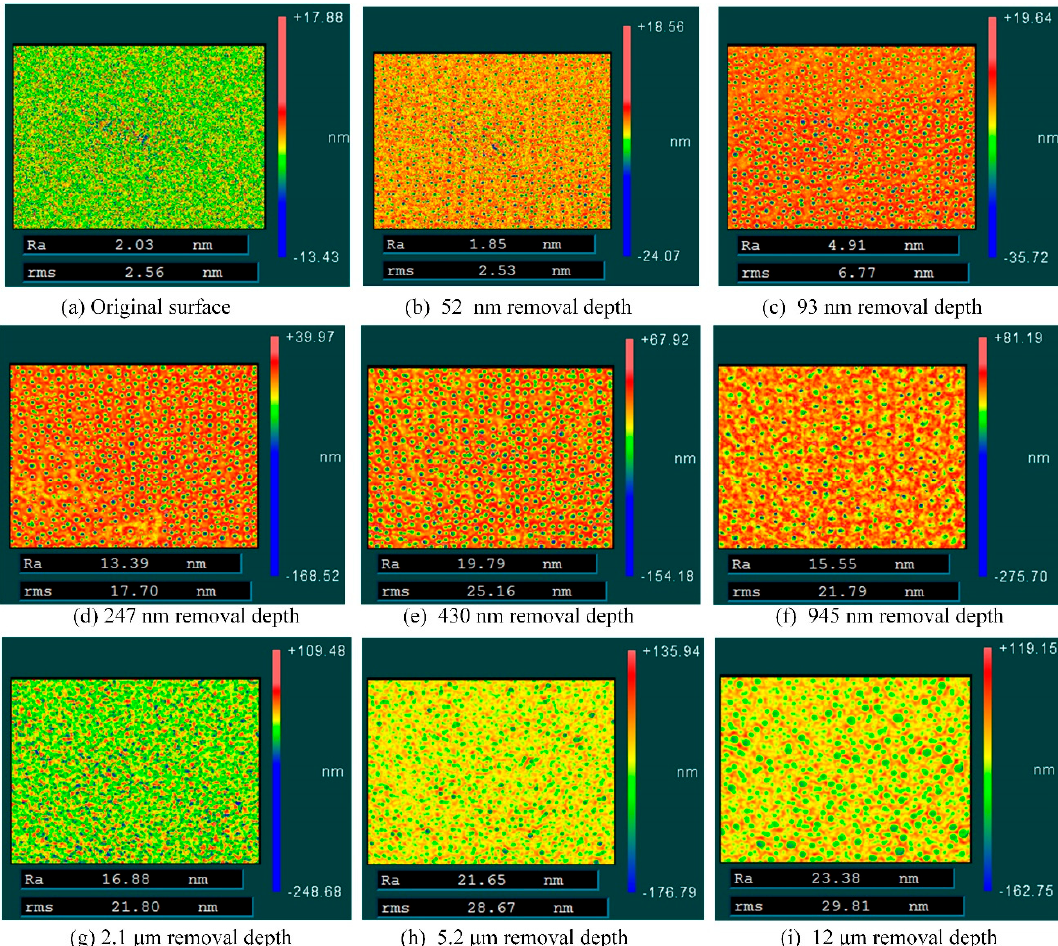
Figure 5. Surface texture under different removal depth after APPP. ( a ) original surface; ( b ) 52 nm; ( c ) 93 nm; ( d ) 247 nm; ( e ) 430 nm; ( f ) 945 nm; ( g ) 2.1 μ m; ( h ) 5.2 μ m and ( i ) 12 μ m.